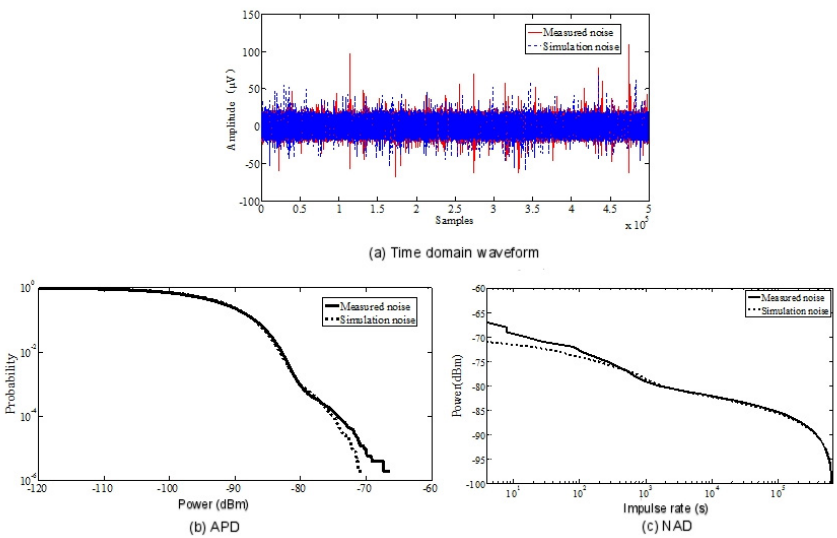
Figure 10. Comparison of measurement and simulation noise. ( a ) Time domain waveform; ( b ) Amplitude probability distribution (APD) value comparison of simulation noise and measurement noise; ( c ) Noise amplitude distribution (NAD) value comparison of simulation noise and measurement noise.